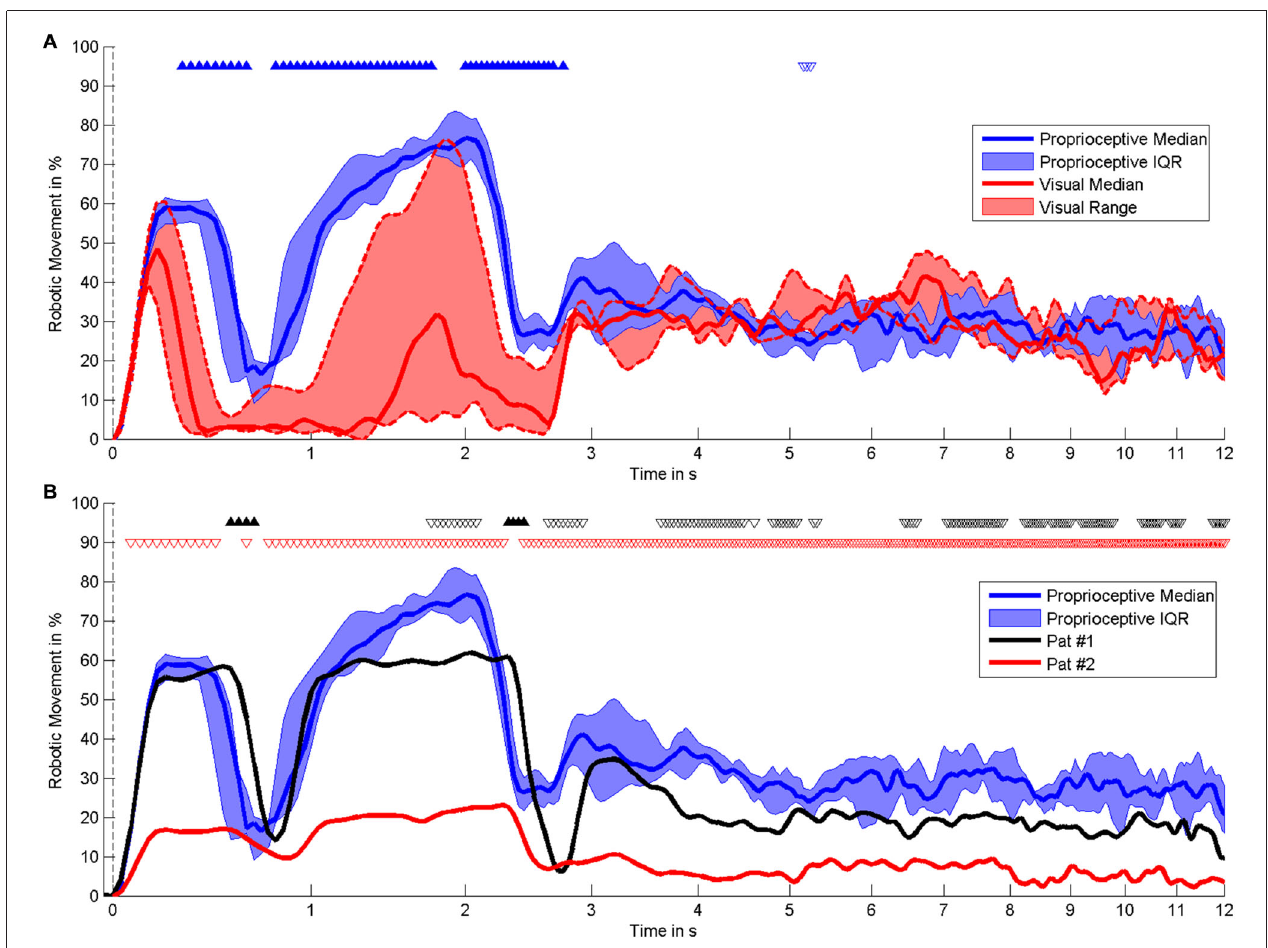
FIGURE 5 | Time course of robotic movement. It shows the occurrence of robotic movement with time on the x-axis (logarithmic scale) and probability of movement on the y-axis. The MI phase begins at 0 s. Smoothing was performed by low-pass filtering below 0–5 Hz. (A) Comparison of different feedback modalities in healthy subjects, i.e., proprioceptive feedback ( n = 6) vs. visual feedback ( n = 3). (B) Comparison of individual stroke patients with proprioceptive feedback with healthy subjects with proprioceptive feedback ( n = 6). The results of the statistical comparison are indicated by triangles, i.e., filled triangles pointing upwards and empty triangles pointing downwards indicate significantly higher and lower movement probability, respectively. Black and red triangles are applied to compare patients #1 and #2 with healthy subjects.